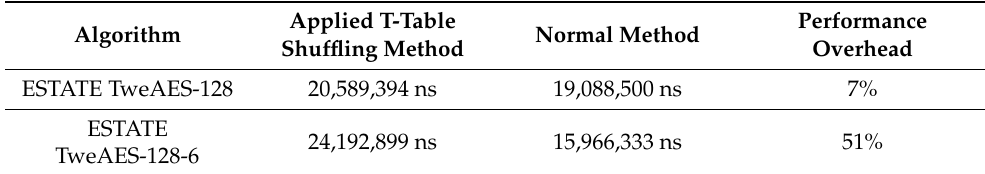
Table 9. Performance overhead measurement result through application of T-table shuffling method (ns: nanosecond).